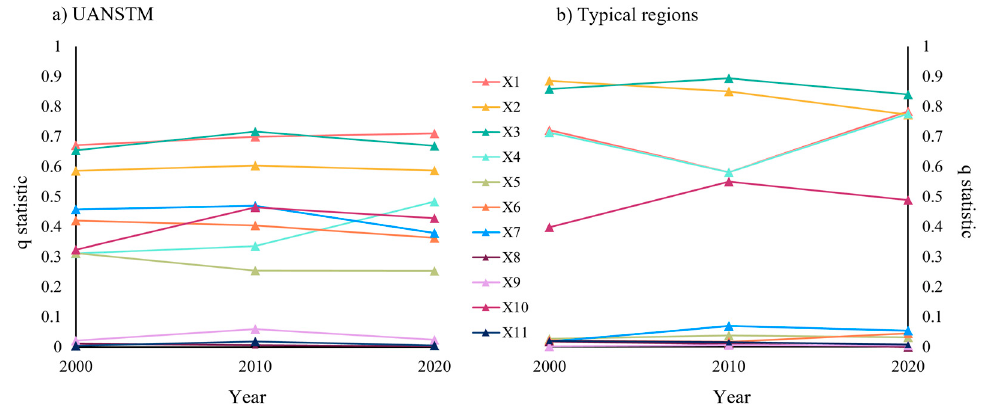
Figure 10. Folding graph of q statistic at different scales.